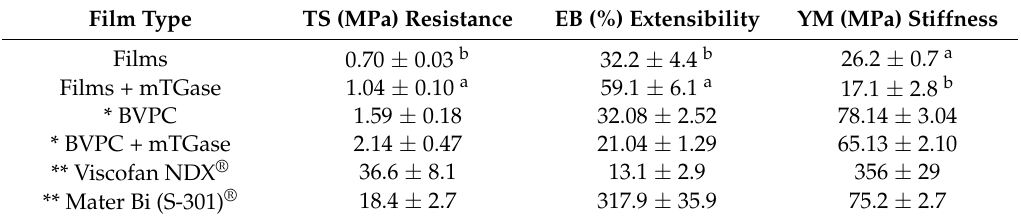
Table 3. Mechanical properties of films cast in the presence and the absence of mTGase compared to commercial plastics.